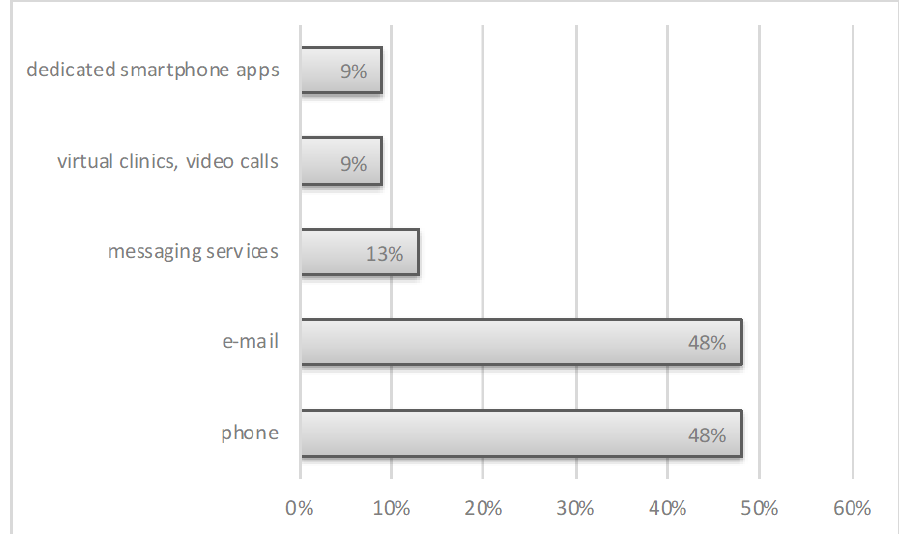
Figure 2. The types of telehealth used in HIV medical care before the COVID-19 outbreak.